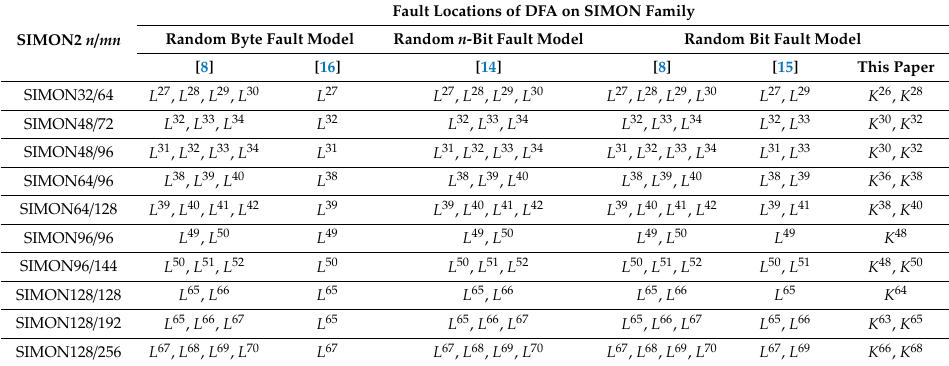
Table 10. Comparison of the fault locations of di ff erential fault analysis (DFA) on SIMON